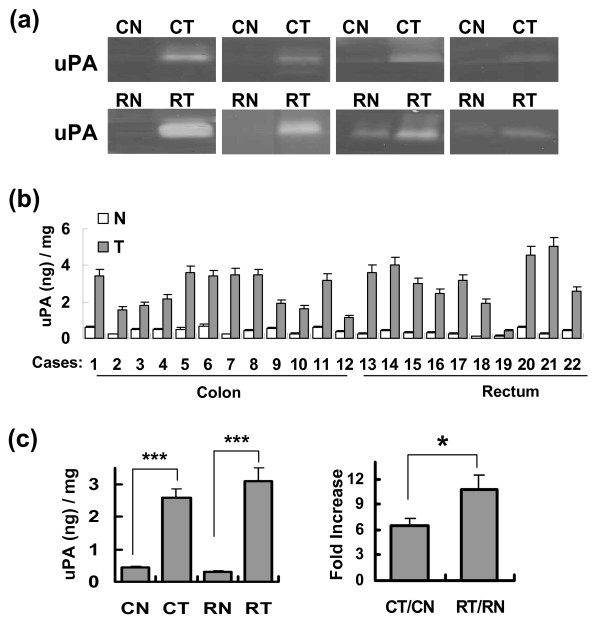
Activity and expression of uPA in tumor tissues andadjacent normal mucosaof colon and rectal cancer patients. (a) Casein-plasminogen zymography of representative specimens of colon tumor (CT) and the corresponding paired adjacent normal colonic mucosa (CN) from colon cancer patients, and rectal tumor (RT) and the corresponding paired adjacent normal rectal mucosa (RN) from rectal cancer patients. (b) Concentration of uPA in tumor tissues and adjacent normal colonic mucosa of colon and rectal cancer patients determined by ELISA. (c) Mean concentration (left panel) and fold increase (right panel) of uPA in tumor tissues compared with normal tissues. uPA levels are significantly increased in rectal cancer patients compared with colon cancer patients. *P < 0.05. ***P < 0.001.